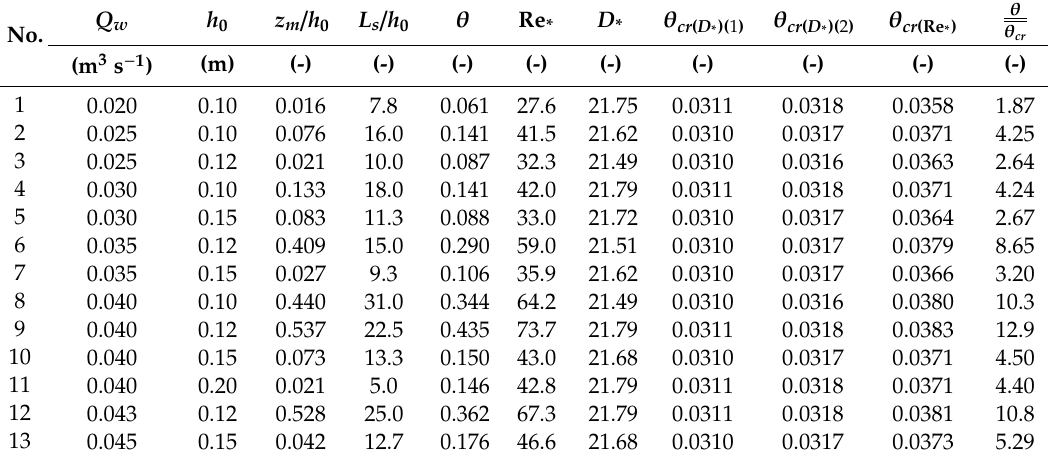
Table A2. Summary table of calculation results—variant II of flume development; stone weir; “live-bed” conditions.